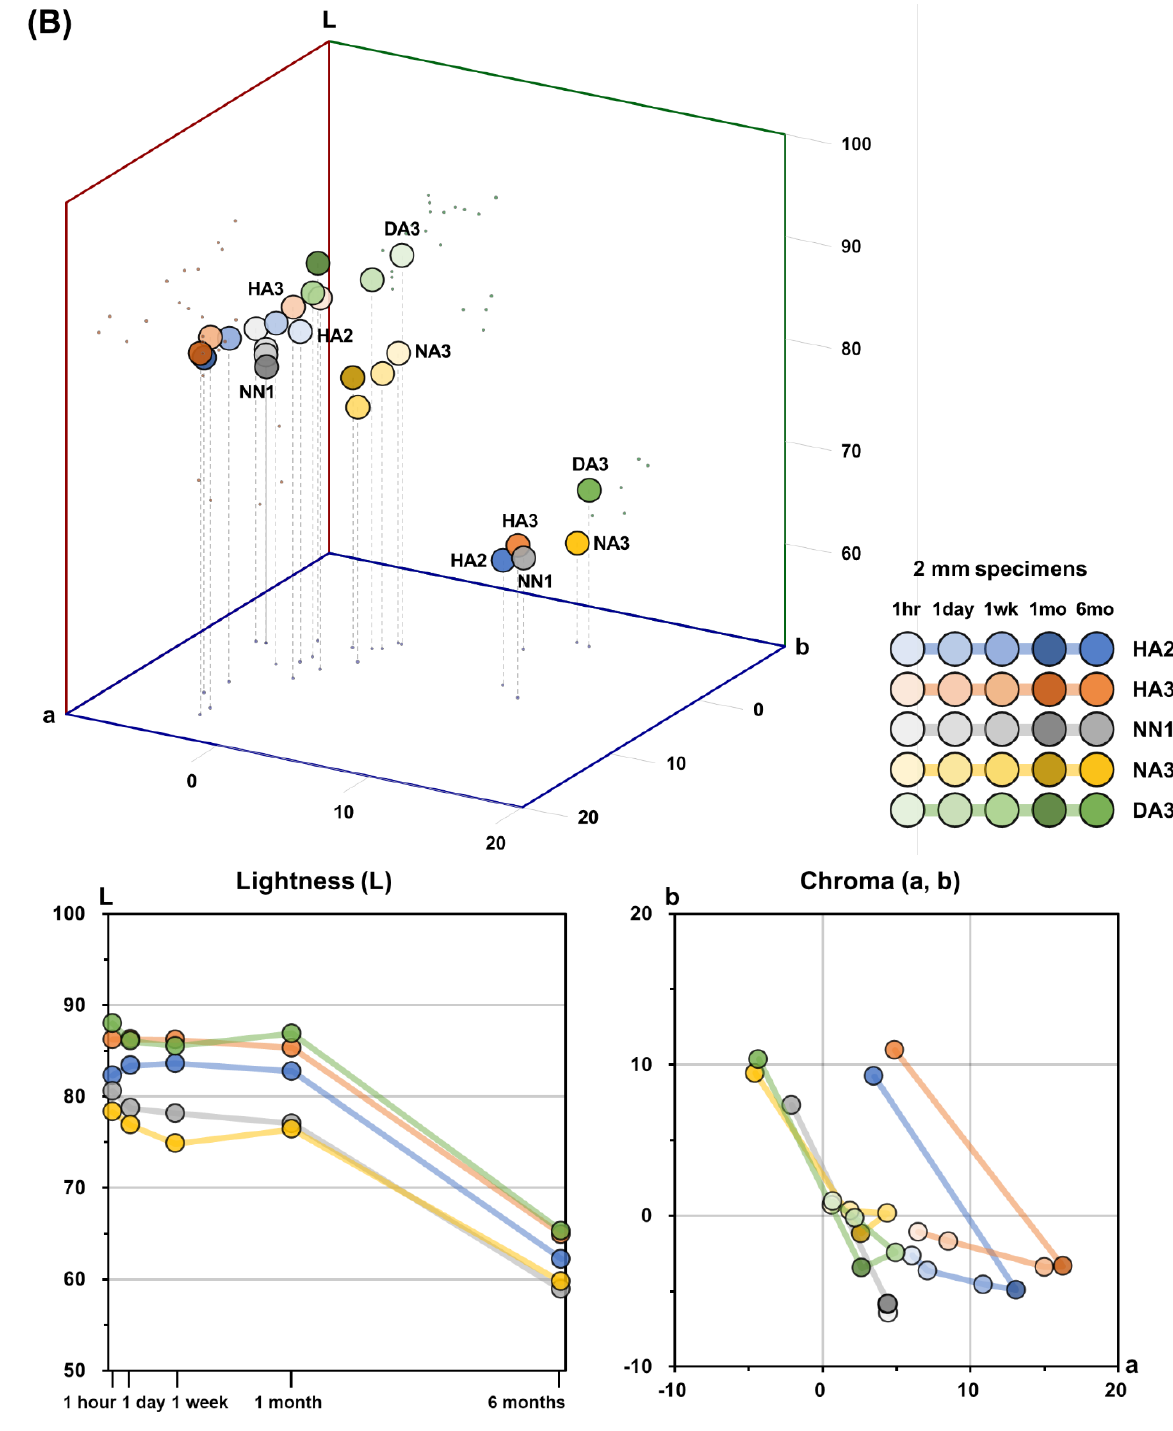
Figure 2. Mean color distribution of the 3D printable material specimens after different storage periods in the CIELAB color space (L*, a*, and b* coordinates). ( A ) 1 mm specimens. ( B ) 2 mm specimens.